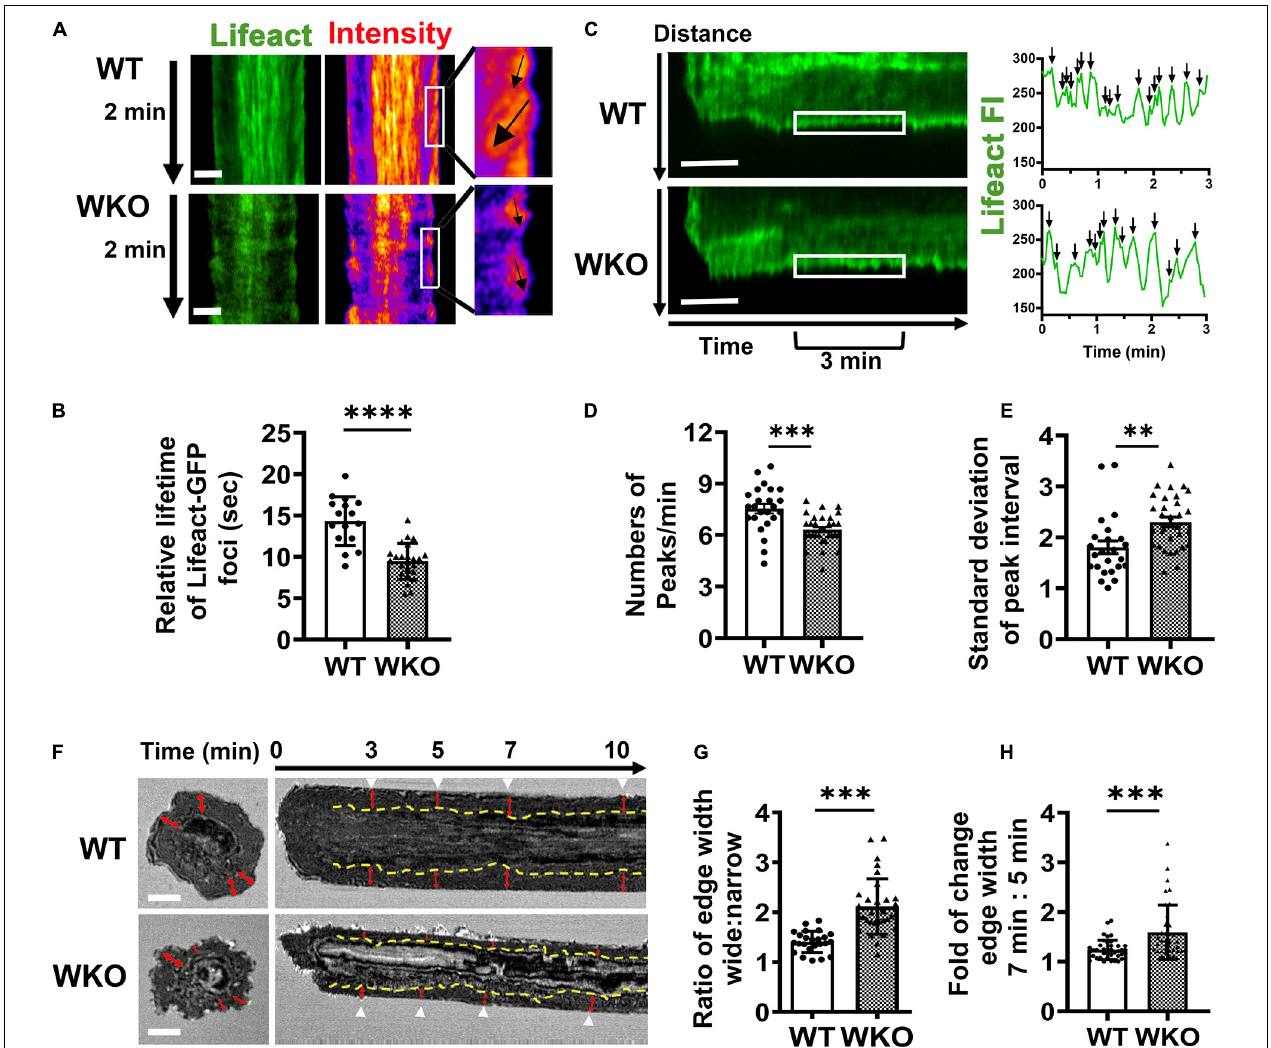
FIGURE 6 | WASp is required for the formation of a steady adherent region surrounding the central signalosome. GCBs isolated from SRBC-immunized Lifeact-GFP mice were incubated with Fab’-PLB and imaged live using IRM and TIRF. (A) Representative kymographs from 2.5 to 4.5 min and their intensity heat maps generated from Lifeact-GFP time-lapse images. White box, peripheral regions for 1 min. Black arrows, tracks of Lifeact foci at an edge region. (B) Relative lifetimes of Lifeact-GFP foci were evaluated by the duration of Lifeact-GFP foci detected in randomly selected kymographs. Data points represent individual cells, the average of 8 ∼ 10 Lifeact foci tracks per cell. (C) Representative Lifeact-GFP kymographs (from the center to the periphery of the contact zone). White box, peripheral regions between 3 and 6 min. FI in the peripheral region (white box) over time was shown in the right panels. Black arrows, individual Lifeact-GFP FI peaks. (D) Numbers of Lifeact-GFP FI peaks per min between 3 and 6 min. (E) Standard deviation (SD) of time intervals between peaks. (F) Representative IRM images at 7 min and kymographs generated from time-lapse IRM images of WT and WKO GCBs. Yellow dashed lines indicate the border between the periphery and center regions of the contact zone based on IRM density. Red arrows indicate the width of the periphery area. White arrow, time. (G) The ratio of the periphery width at the wider side relative to the narrow side. Data points represent the average of the ratios at 3, 5, 7, and 10 min in individual cells. (H) The fold of change in the periphery width between 5 and 7 min. Data points represent individual cells. Scale bars, 3 µ m. The results were the average ( ± SD) of 20 ∼ 30 individual cells per condition. n = 4. ** p < 0.01, *** p < 0.001, and **** p < 0.0001, unpaired Student’s t -test or one-way